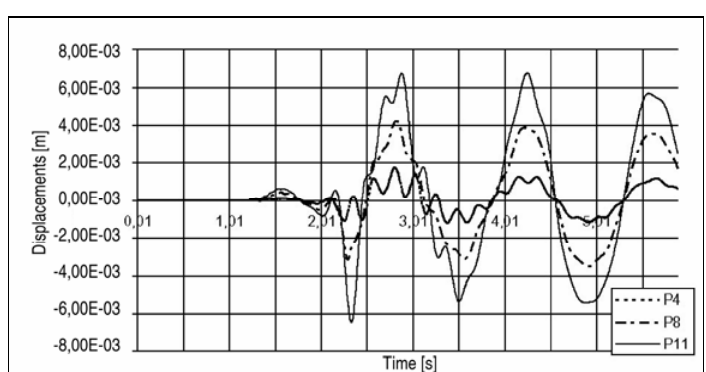
Fig 15 . Horizontal displacements